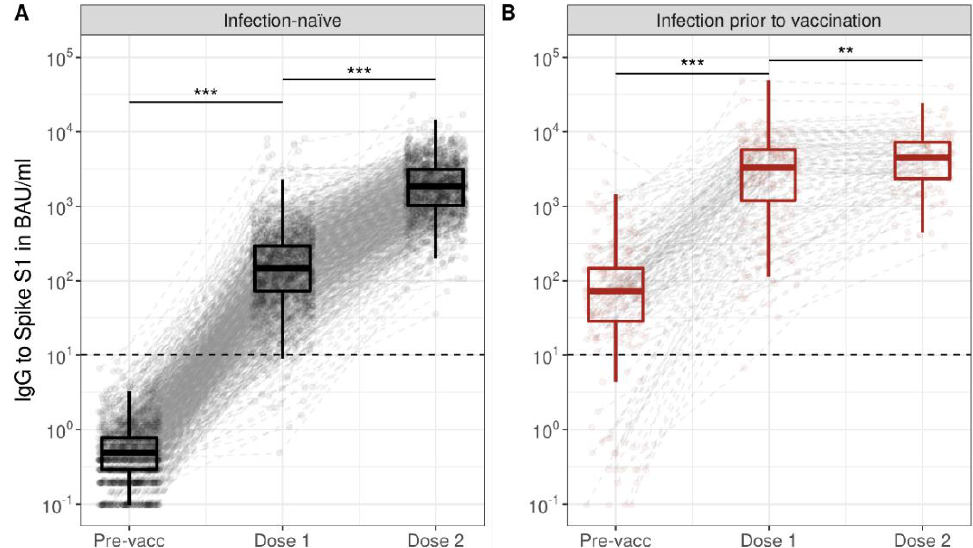
Figure 1. Spike S1-specific IgG kinetics following the primary series of BNT162b2 vaccination in infection-naive participants ( A ) and participants with a SARS-CoV-2 infection prior to vaccination ( B ). Boxplots show results for all participants at each time point, while dots and dashed grey lines show measurements and their trajectory between time points per participant. Results are shown for total of 1500 infection-naive participants and 235 participants with a SARS-CoV-2 infection history; measurements were not available at every time point for each participant. Spike S1 IgG concentrations were expressed in international binding antibody units (BAU) using the 20/136 NIBSC standard and were taken prior to vaccination (Pre-vacc), one month following the first (Dose 1), and one month following the second vaccination dose (Dose 2). The horizontal dashed line represents the threshold for seropositivity to Spike S1. Asterisks indicate p -values from Wilxocon Mann–Whitney U test (unpaired), when the Wilcoxon signed-rank test was performed in only paired samples all p -values were <0.001. IgG: immunoglobulin G; BAU: binding antibody units; ***: p < 0.001; **: p = 0.002.